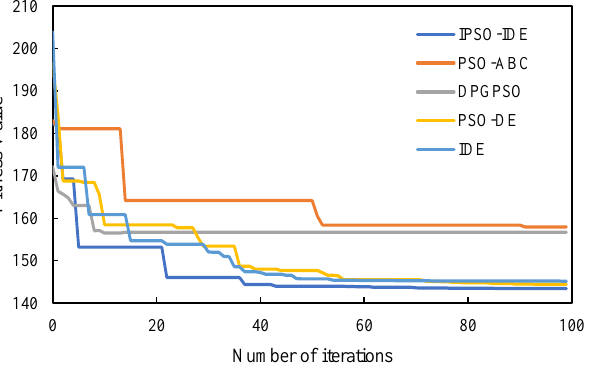
Figure 14. Convergence curves of optimal fitness values based on different algorithms in environment 4. Table 7. Path planning results of different algorithms in environment